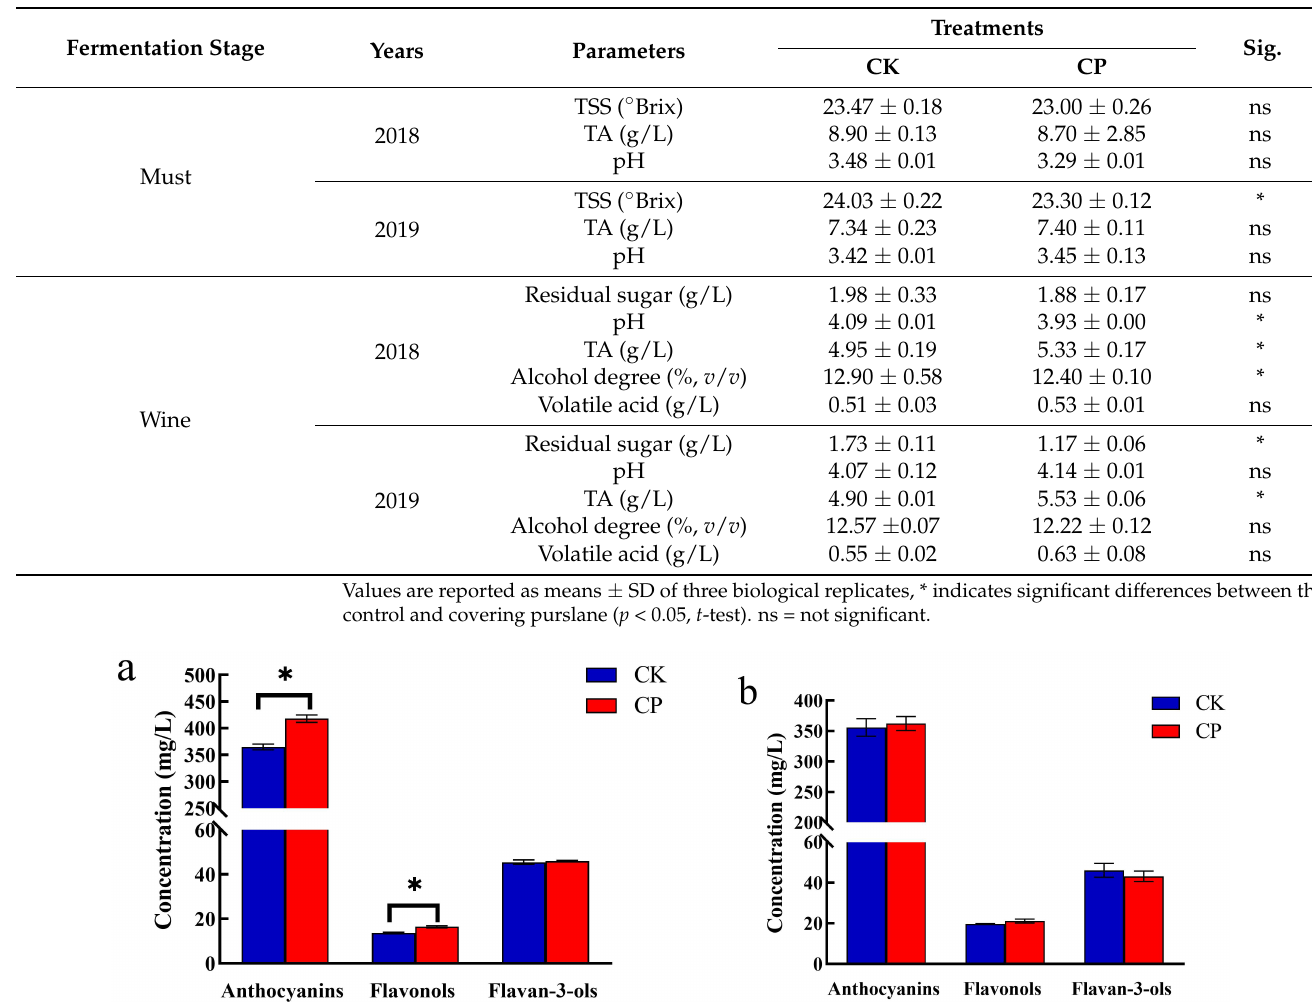
Table 5. Must and wine physicochemical parameters of the clean tillage (CK) and covering purslane (CP).